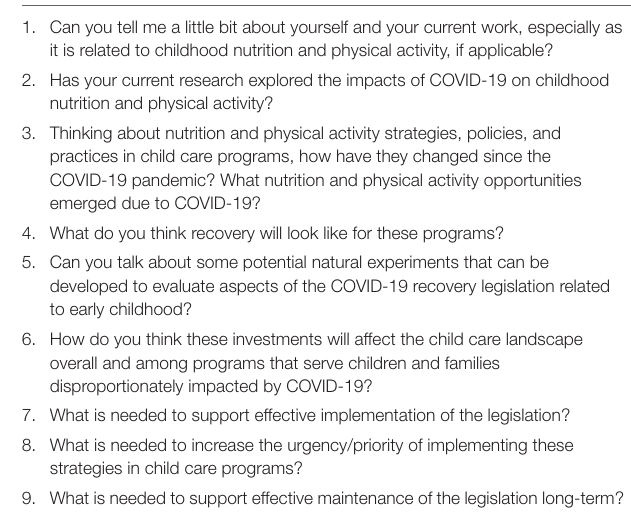
TABLE 1 | Semi-structured interview